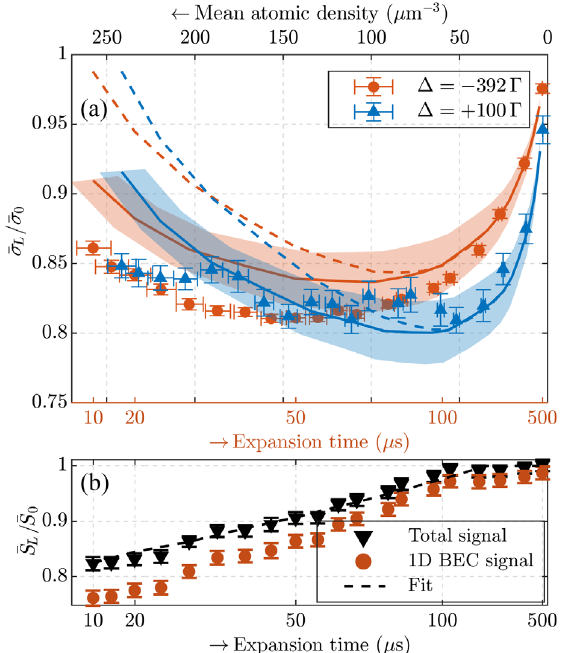
= ¯ σ 0 of the 1D FIG. 3. (a) Relative average transverse width ¯ σ L BEC after TOF with ( ¯ σ ) and without ( ¯ σ 0 ) LIDD interaction at L different expansion times (atomic densities). The blue triangles [red circles] depict results for a laser detuning of Δ ¼ þ 100 Γ [ Δ ¼ − 392 Γ ] with a saturation parameter s ¼ 708 ð 20 Þ × 10 − 6 [ s ¼ 319 ð 11 Þ × 10 − 6 ] and mean atom number N ¼ 6600 ð 130 Þ [ N ¼ 7450 ð 60 Þ ]. The reduction of the relative mean transverse width is compared to the theoretical prediction with (solid lines) and without (dashed lines) considering the observed atomic loss, respectively [see the text and dashed line in (b)]. The shaded areas are theoretical predictions that account for a (cid:3) 10% variation of the atom number and the saturation parameter. (b) Integrated fluores- ¯ S cence signal after LIDD interaction compared to the signal L ¯ S 0 [for the dataset shown in (a) with without laser pulse interaction Δ ¼ − 392 Γ , losses for Δ ¼ þ 100 Γ are similar]. The black triangles show the integrated signal of the entire light sheet image, the red circles the signal in the bulk BEC; see also Fig. 9. For densities smaller than 50 atoms = μ m 3 , only the density-indepen- dent recoil due to spontaneous emission induced by the laser pulse is observed. For larger densities, additional mechanisms like superradiance and possibly light-assisted collisions cause atom loss of up to 25% (red circles). Adding these losses in the simulations greatly reduces the difference between theory and data [compare dashed and solid lines in (a)]. Error bars depict the standard error of the